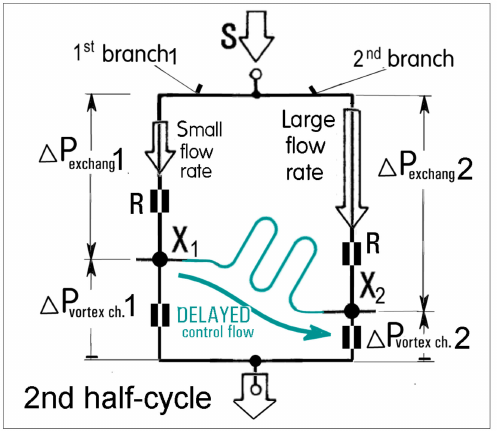
Figure 29. During the second half of the oscillation cycle, the direction of the control flow is